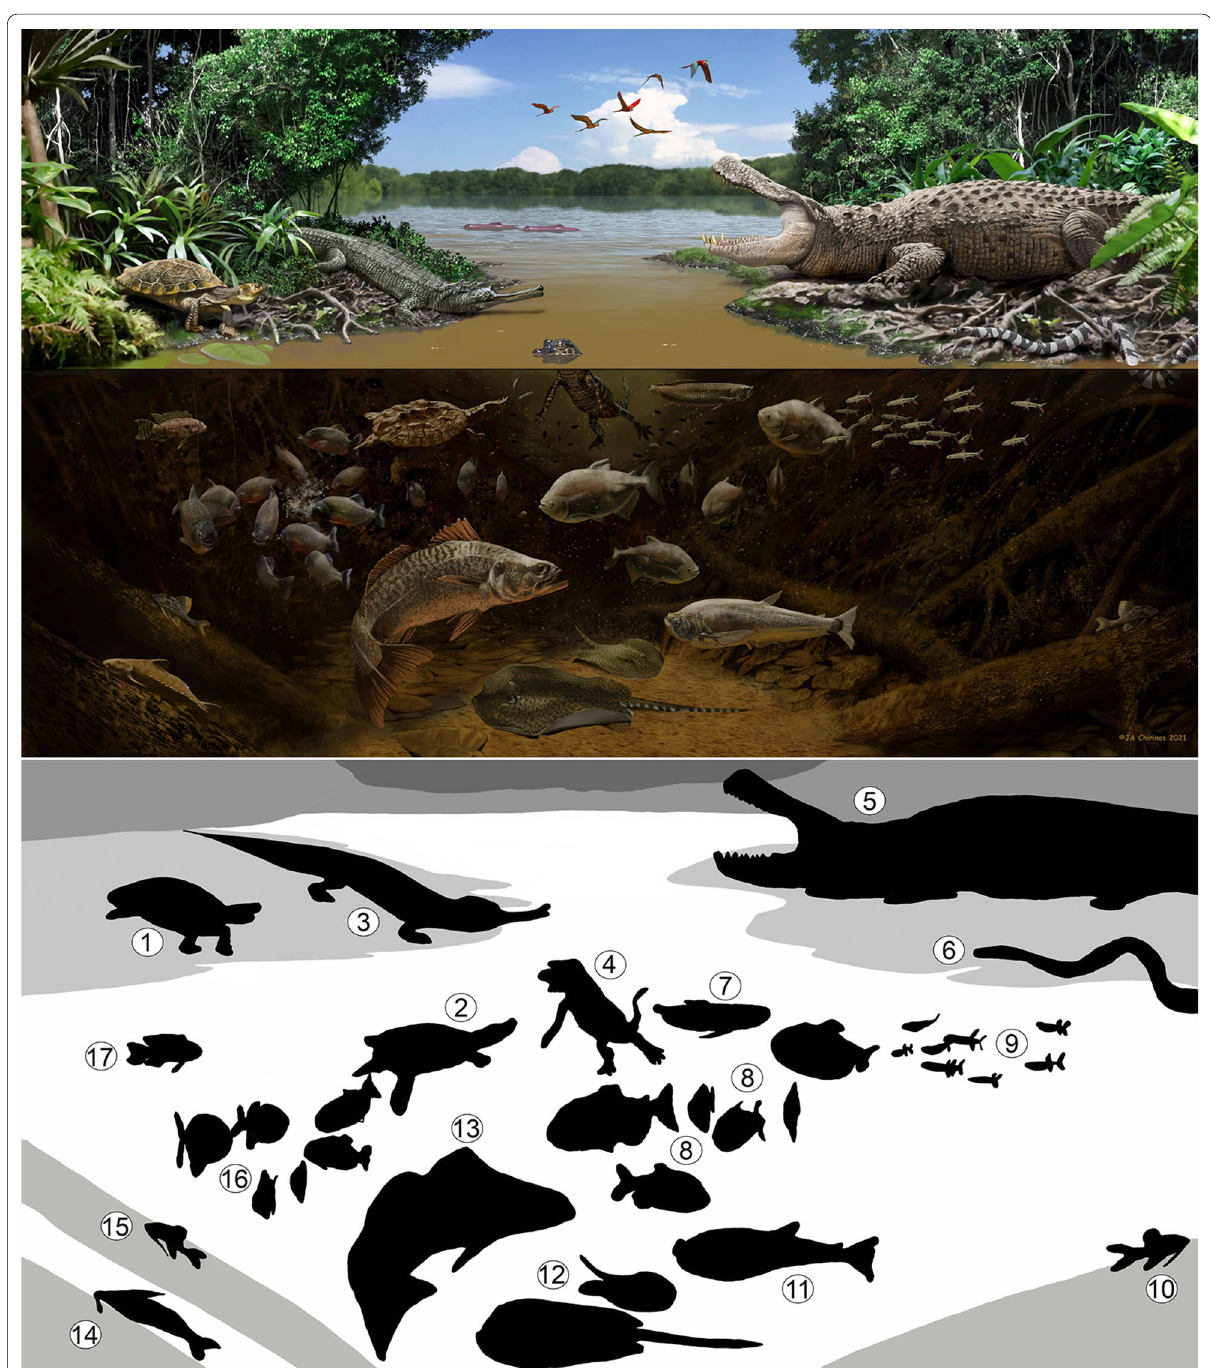
Fig. 12 (Top) Life reconstruction of the Pebas Formation faunal assemblage during the middle Miocene. Artist: Jaime Chirinos. (Bottom) Key of the reconstruction. (1) Podocnemididae indet. (2) † Chelus colombianus . (3) Gryposuchinae (Gavialidae) indet. (4) Caimaninae indet. (5) † Purussaurus sp. (6) † Colombophis portai . (7) ?Osteoglossoidei indet. (8) Colossoma cf. C . macropomum . (9) Hemiodus sp. (10, 15) Loricariidae ident. (11) Cynodontidae indet. (12) † Potamotrygon canaanorum . (13) Sciaenidae indet. (14) Doradidae indet. (16) cf. Serrasalmus sp. (17) Cichlidae